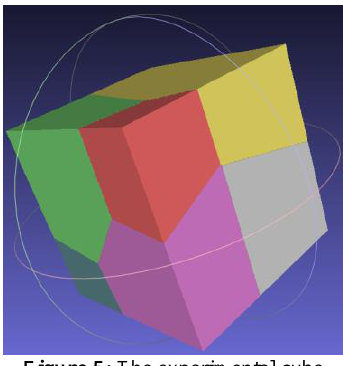
Figure 5: The experimental